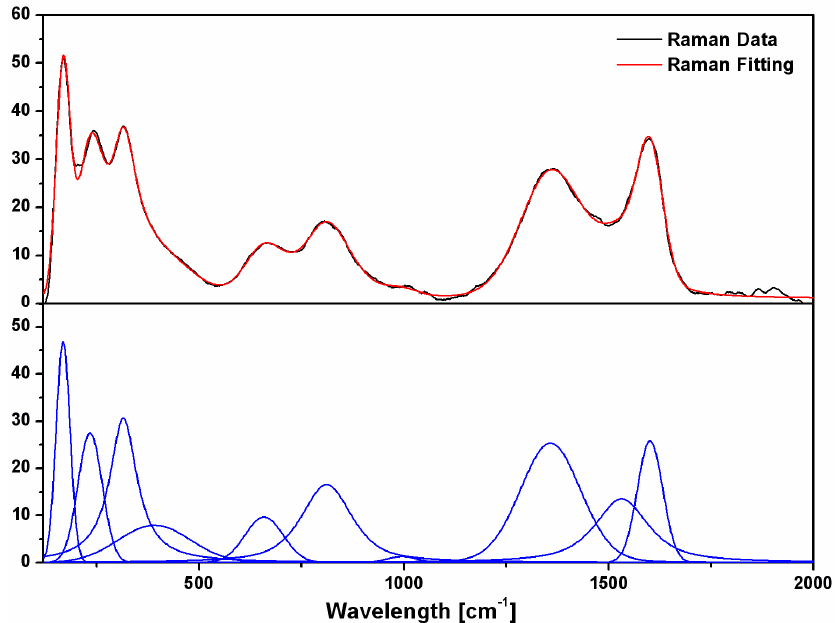
Figure 3. Example of fitting Raman spectra: top graph shows measured Raman spectra (black line) together with the best fit (red line); bottom graph shows the individual deconvoluted peaks resulting from the fitting.